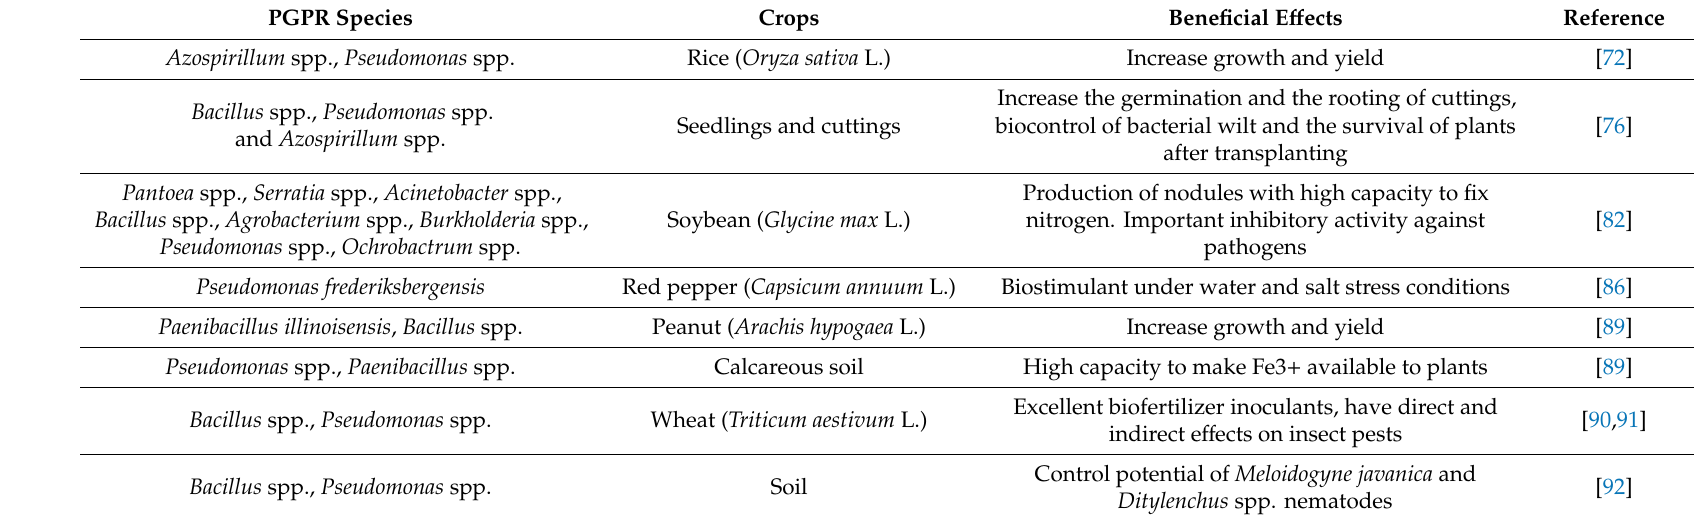
Table 2. Beneficial e ff ects of plant growth-promoting rhizobacteria in agroforestry